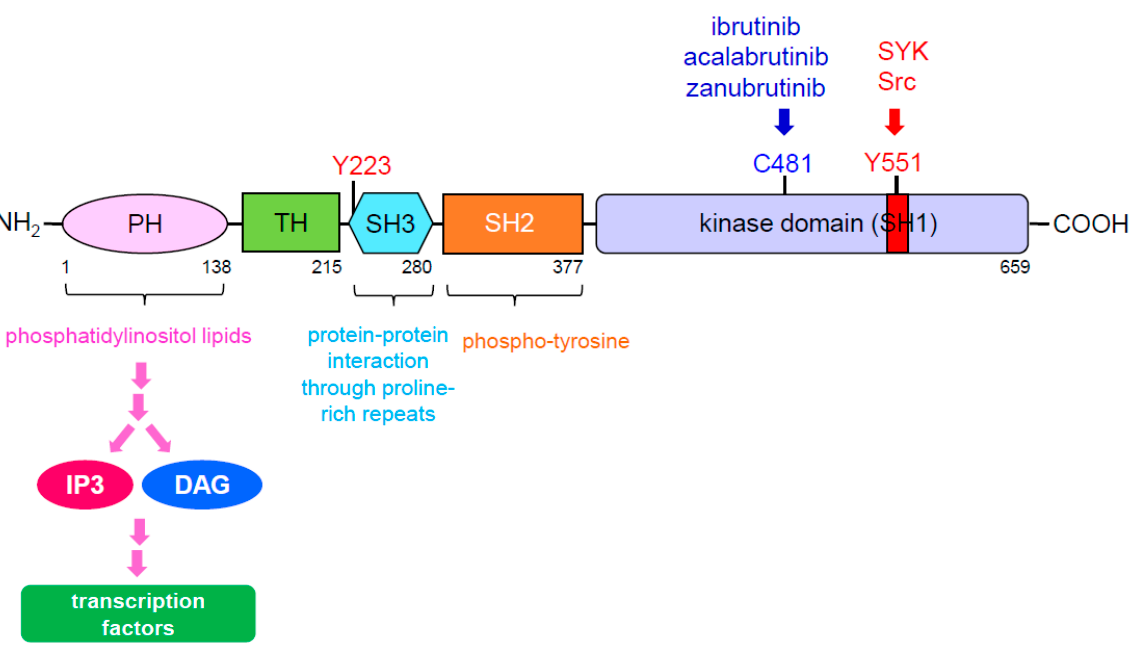
Figure 2. BTK domain diagram. BTK contains five domains, including a PH domain at the amino terminus, a TH domain, a SH3 domain, a SH2 domain and a tyrosine kinase domain at the carboxyl terminus. The PH domain of BTK is able to interact with phosphatidylinositol lipids which allows it to eventually regulate transcription factors through IP3 and DAG. The SH3 domain of BTK mediates protein-protein interactions through proline-rich repeats and also contains a tyrosine at 223 position (Y223), an autophosphoryaltion site of BTK. The SH2 domain of BTK can interact with phospho-tyrosine. The kinase domain of BTK, also known as the SH1 domain contains a tyrosine at 551 position (Y551) with the activation loop. Once Y551 is phosphorylated by SYK or Src, it results in autophosphrylation of Y223 to fully activate BTK. In addition, cysteine 481 (C481) is the site to which BTK inhibitors covalently bound. Abbreviation: PH: pleckstrin homology; TH: Tec homology; SH: Src homology; IP3: inositol triphosphate; DAG: diacylglycerol.